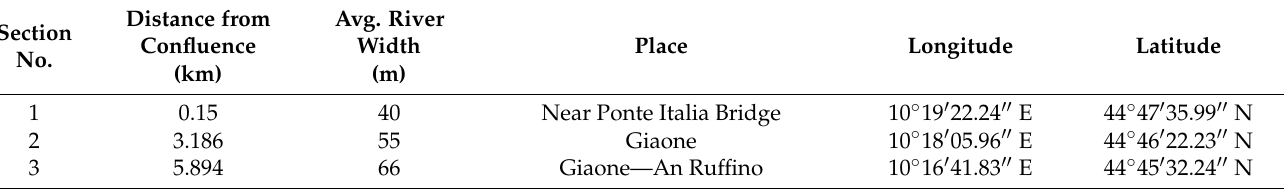
Table 1. Salient features of the sections and reference coordinates of the